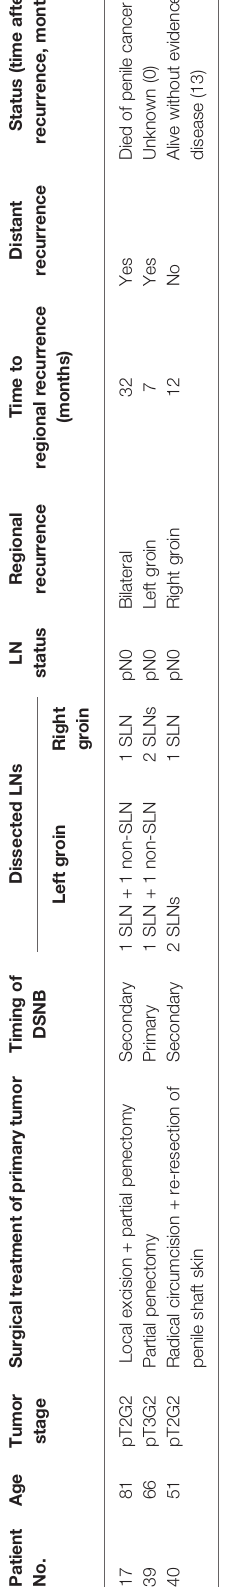
TABLE 5 | Results of histopathological reexamination of SLNs from false- negative patients.